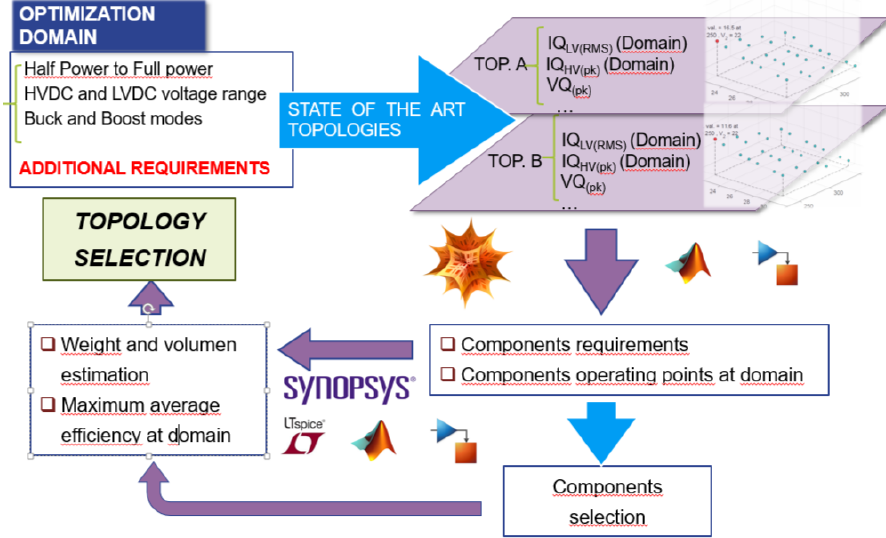
Figure 1. Methodology followed in this work for topology comparison and architecture